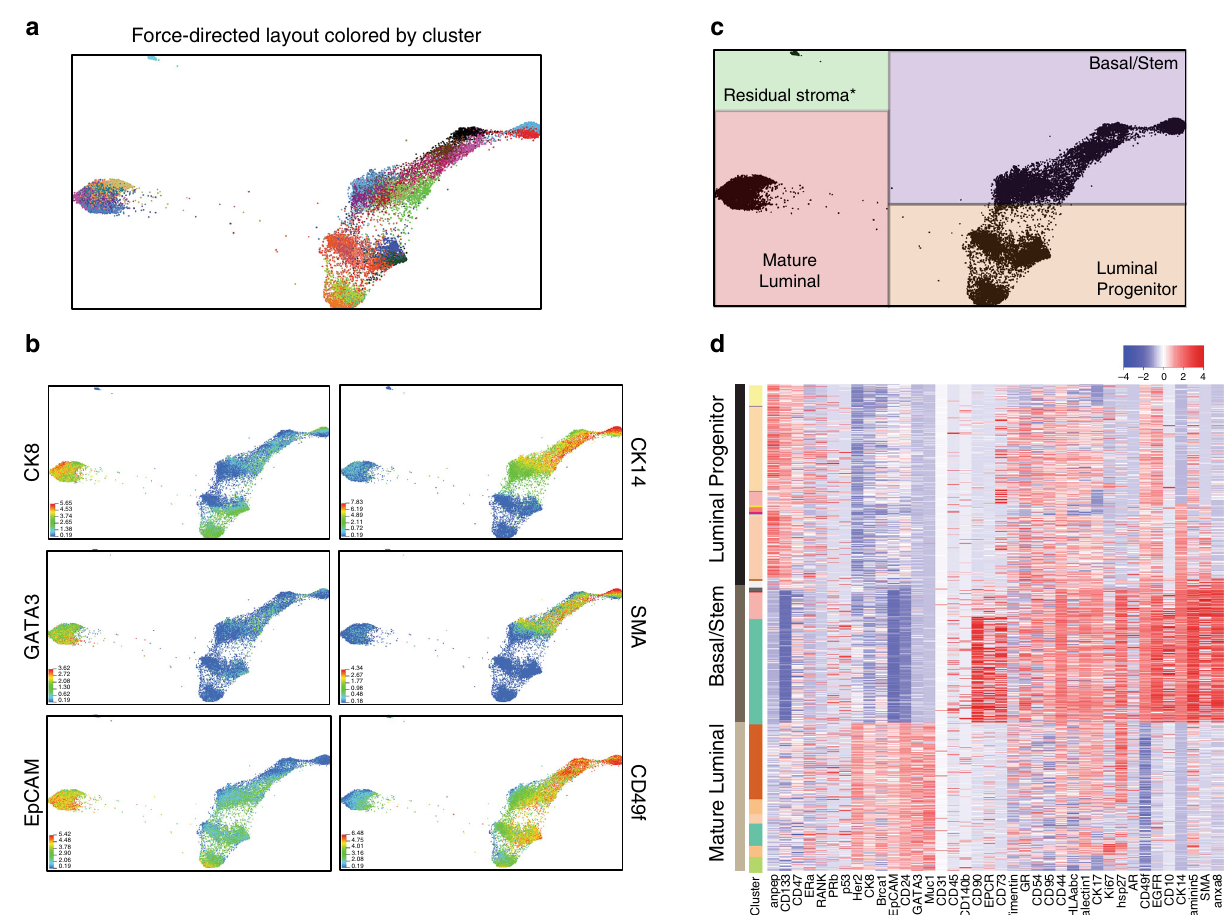
Fig. 3 Mass cytometry assessment of mammary cell subtypes in normal breast organoids. a Force-directed layout depicting CyTOF analysis of 12 normal mammary organoid cultures. Each dot represents one cell and is colored by X-shift-de fi ned cluster. b The expression levels of markers used to de fi ne major mammary populations are shown (warmer colors = higher expression levels). c Delineation of major mammary lineages on the force-directed layout, as determined by marker expression in b . d Heat map showing the expression levels of the indicated markers in the cells from a representative organoid culture (red = high expression, blue = low expression). The 38 markers in the CyTOF panel are shown on the x -axis, and individual cells on the y -axis are ordered based on X-shift 12 cultures (described below), with only a small number of residual fi broblasts present in one culture. CyTOF results were analyzed using the X-shift clustering algorithm to fi nd groups or clusters of similar cells, based on the expression levels of the 38 mammary markers. Clusters were then displayed by force-directed layout (Fig. 3a). As described else- where 27 , here each dot represents one cell and the proximity of cells as graphed corresponds to the similarity of their protein